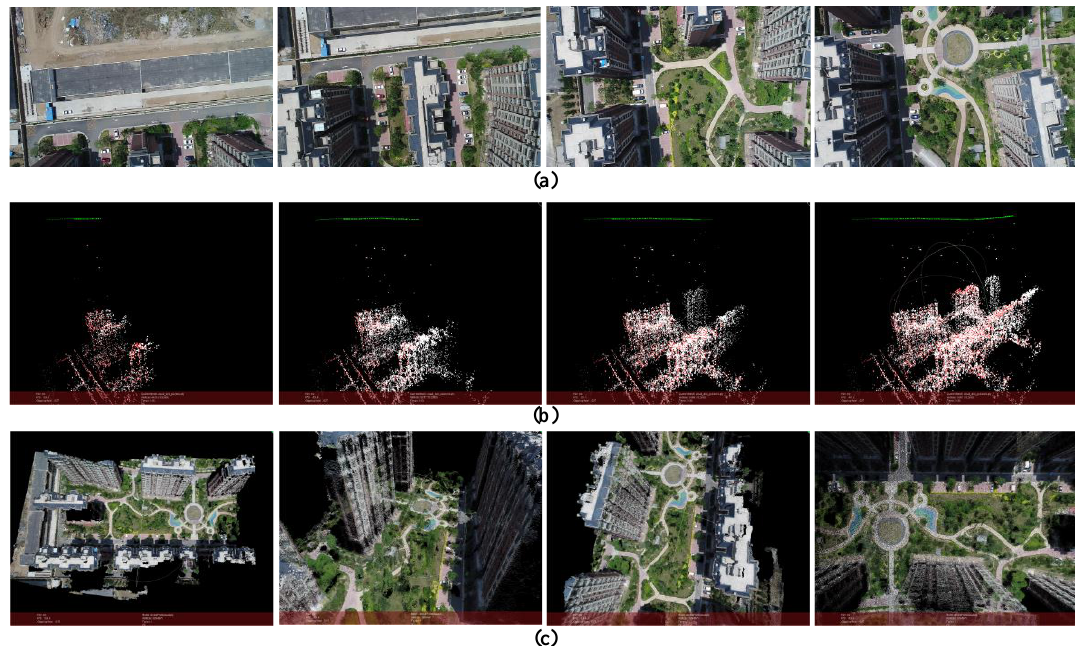
Figure 15. Reconstruction result of buildings. ( a ) Part of the images used for reconstruction; ( b ) Structure calculation of image queue SfM (green points represent the positions of the camera); ( c ) Dense point cloud of the scene.